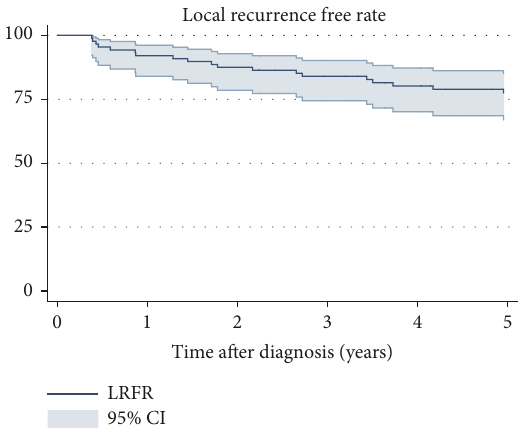
Figure 4: Kaplan-Meier estimates of overall survival by surgical margin. 95% confidence intervals. Figure 5: Local recurrence free rate of 88 patients with soft tissue sarcoma in the thoracic wall. 95% confidence